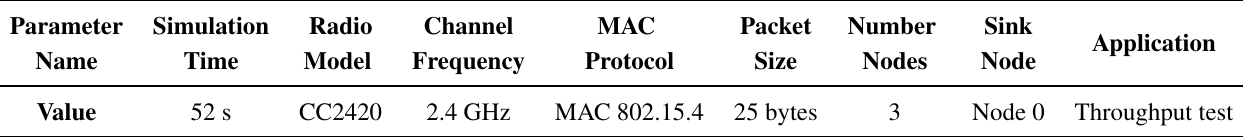
Table 4. Simulation parameters.